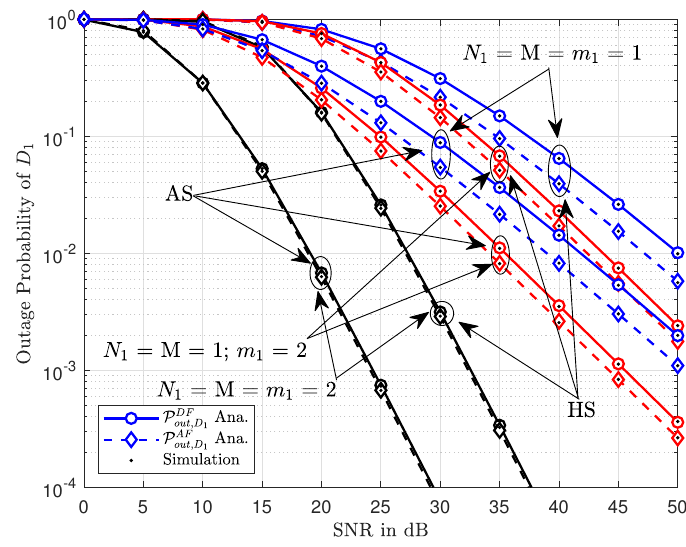
Figure 4. The outage probability of D 1 versus transmit SNR.